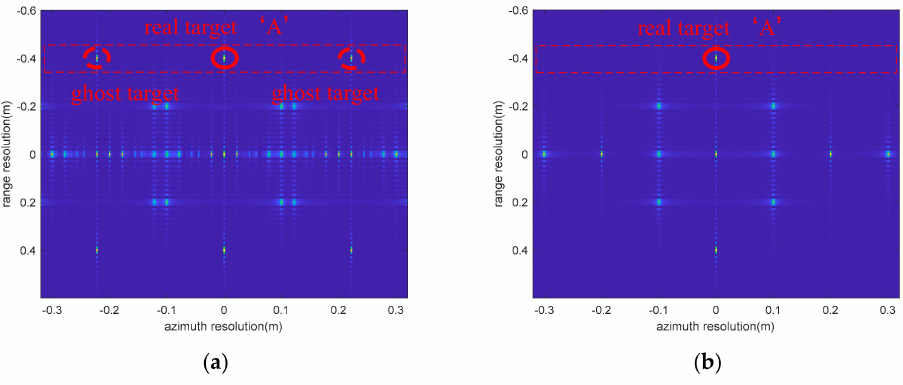
Figure 9. Imaging results without ( a ) and with ( b ) compensation under condition 1.